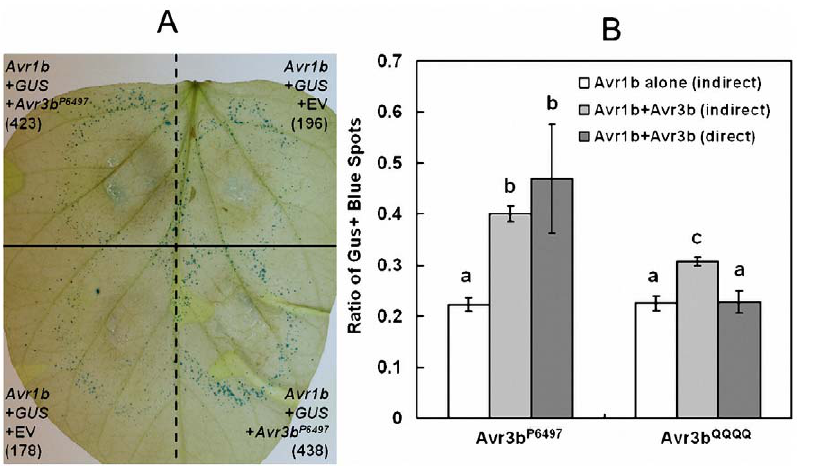
Figure 7. Avr3b suppresses ETI triggered by P.sojae effector Avr1b. Suppression of Avr1b-triggered PCD in soybean cultivar L77–1863 (Rps1b) by Avr3b P6497 and Avr3b QQQQ measured by indirect and direct double barrel particle bombardment assays. ( A ) Side-by-side comparison of cell death triggered by co-bombardment of Avr1b alone compared to Avr1b + Avr3b P6497 on Rps1b soybean. Numbers in parenthesis indicate total GUS positive spots counted for each treatment on the leaf shown. Co-bombardments occur horizontally and are separated by dashed lines. Replicate bombardments are separated by the solid black line. ( B ) Quantitation of suppression by indirect and direct co-bomardment assays. For the indirect assay the number of GUS-expressing spots surviving in the presence of Avr1b on Rps1b soybean, was measured relative to a parallel GUS-only control in the presence (light grey bars) or absence (white bars) of Avr3b P6497 or Avr3b QQQQ . For the direct assay (dark gray bars) one barrel delivered DNA encoding Avr1b + Avr3b P6497 or Avr3b QQQQ and the other barrel delivered Avr1b DNA only. The direct ratio was then multiplied by the cell survival in the presence of Avr1b alone on Rps1b Soybean (white bars) to enable comparison to the results of the indirect assays. Based on the Wilcoxon signed ranks test (direct assays) or the Wilcoxon rank sum test (indirect assays and comparisons of two direct assays), outcomes that were significantly different p , 0.001 are marked with different letters.